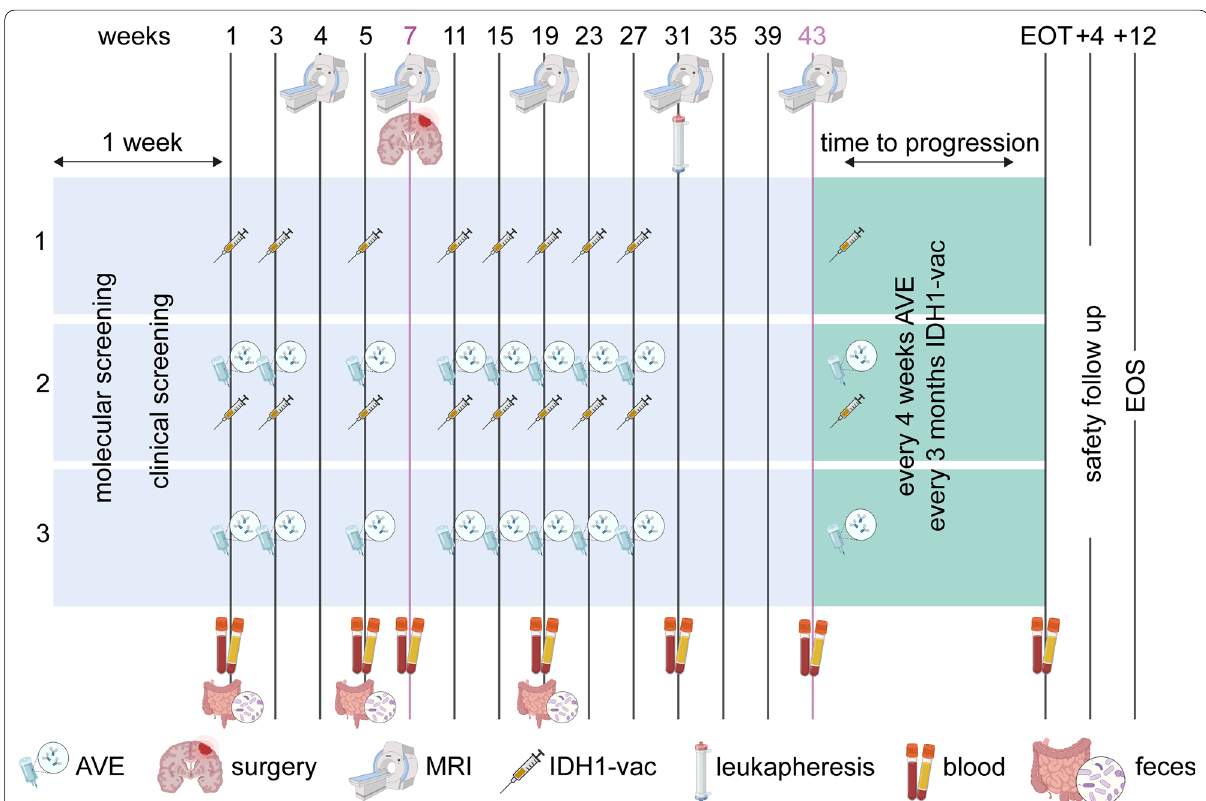
Fig. 1 AMPLIFY‑NEOVAC flow chart. Neoadjuvant and adjuvant immunotherapy will be administered to 48 evaluable patients. In arm 1, 12 patients will receive IDH1‑vac; in arm 2, 12 patients will receive the combination of IDH1‑vac and AVE, and in arm 3, 24 patients will receive AVE only. Until disease progression according to iRANO criteria, treatment will be administered over a period of maximum 43 weeks (primary treatment phase) followed by facultative maintenance